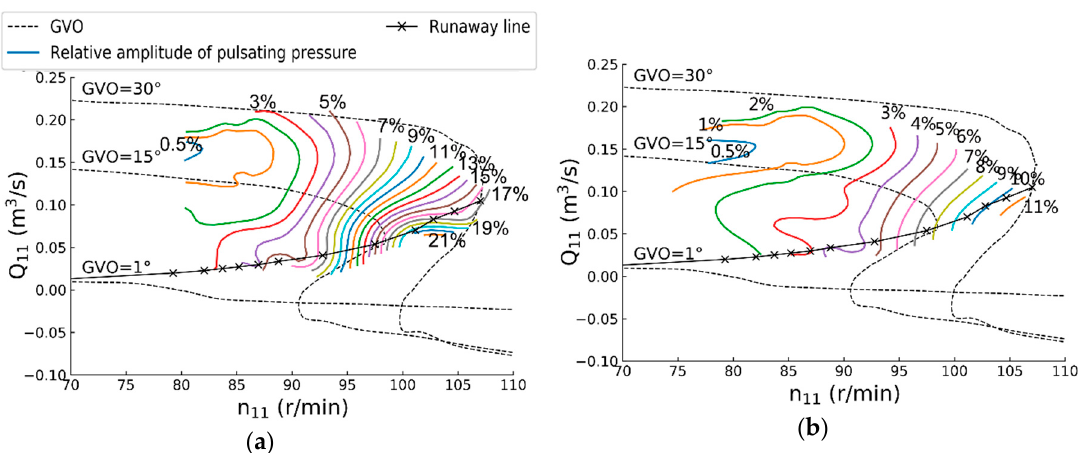
Figure 4. Peak-to-peak diagrams of pulsating pressures in a model pump turbine at ( a ) the spiral case and ( b ) the draft tube.